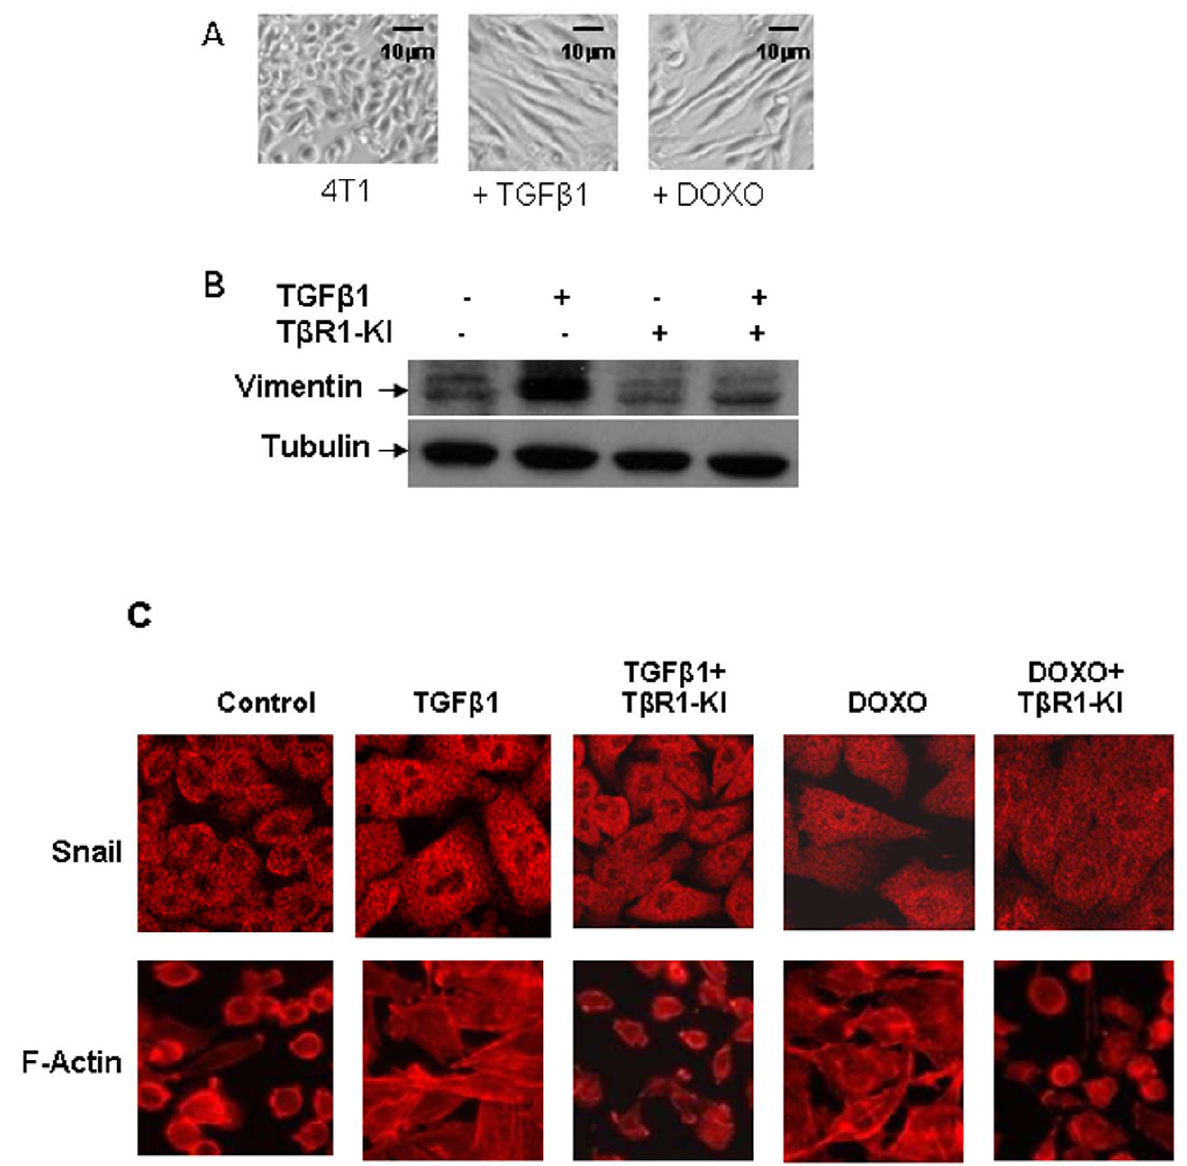
Figure 3. Inhibition of Doxorubicin- and TGF b -induced EMT by T b RI-KI in murine 4T1 cells. A. Representative pictures of 4T1 cells with mesenchymal morphology after treatment with TGF b 1 (2 ng/ml) or doxorubicin (25 nM) for 7 days ( 6 100 magnification). B. 4T1 cells were treated with or without TGF b 1 (2 ng/ml) or TbRI-KI (500 nM) for 7 days. Cell lysates were analyzed by western blotting with antibody to Vimentin and tubulin. C. 4T1 cells were treated with TGF b 1 (2 ng/ml) or doxorubicin (25 nM) in the presence or absence of TbRI-KI (500 nM) for 7 days. The treated and non-treated 4T1 cells were harvested and about 4 6 10 3 cells were seeded on a 8-well Lab-Tek chambered coverglass. After 24 hours, the cells were stained with Rhodamine phalloidin for F-actin or an antibody to Snail. Fluorescent images were taken with a confocal